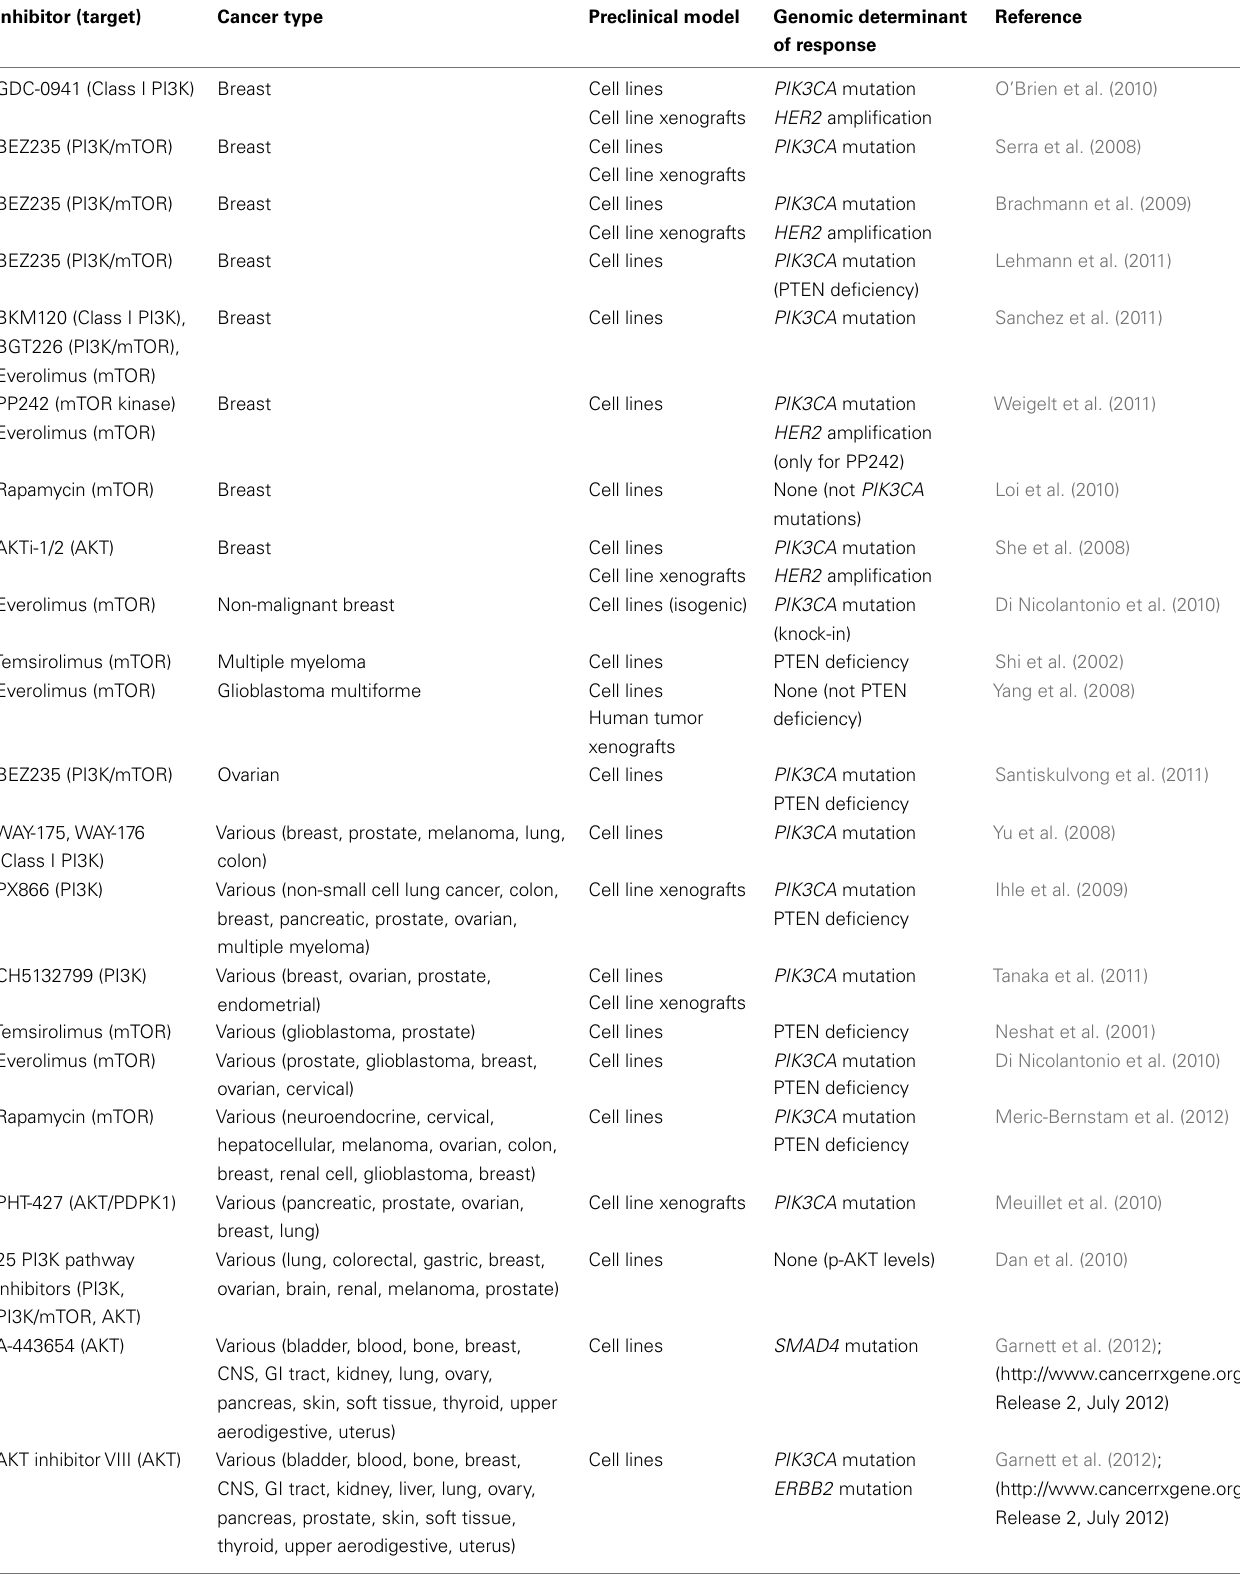
Table 2 | Genomic determinants of response to PI3K pathway inhibitors identified in preclinical cancer